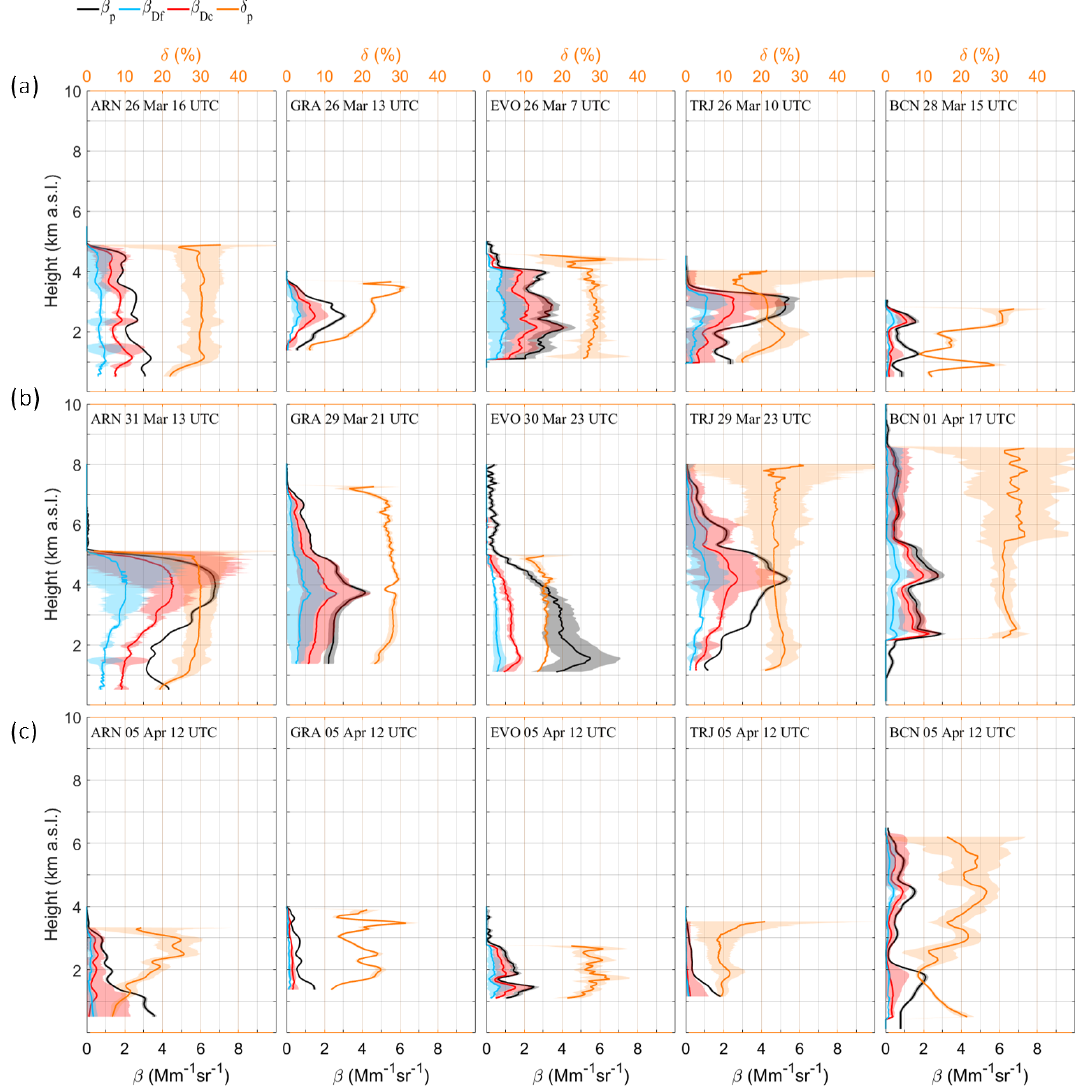
Figure 4. Profiles of the optical properties for representative cases (date and time are shown in each panel) illustrating: (a) the arrival of the dust event, (b) the maximum dust incidence, and (c) the final stage of the event, as observed at (from left to right) ARN, GRA, EVO, TRJ, and BCN. The total β p (black) and those separated into dusty components ( β Df , blue, and β Dc , red), together with δ p (orange) and with their errors bands (shaded areas) are